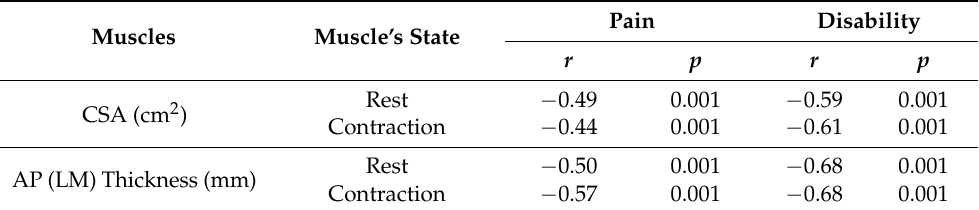
Table 4. The relation between the LM muscles CSA and thickness with pain and disability in patient groups (at